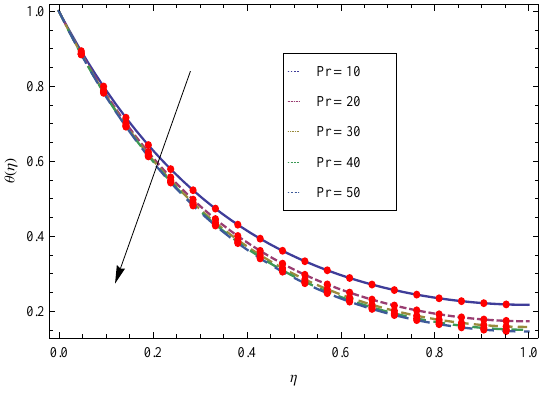
Figure 13. The effect of Kr on φ ( η ) for h = − 0.9, λ = 0.5, S = 0.7,Pr = 0.5,Ec = 0.5,Nb = 0.7, Nt = 0.1, β = 1 and Sc = 0.5.